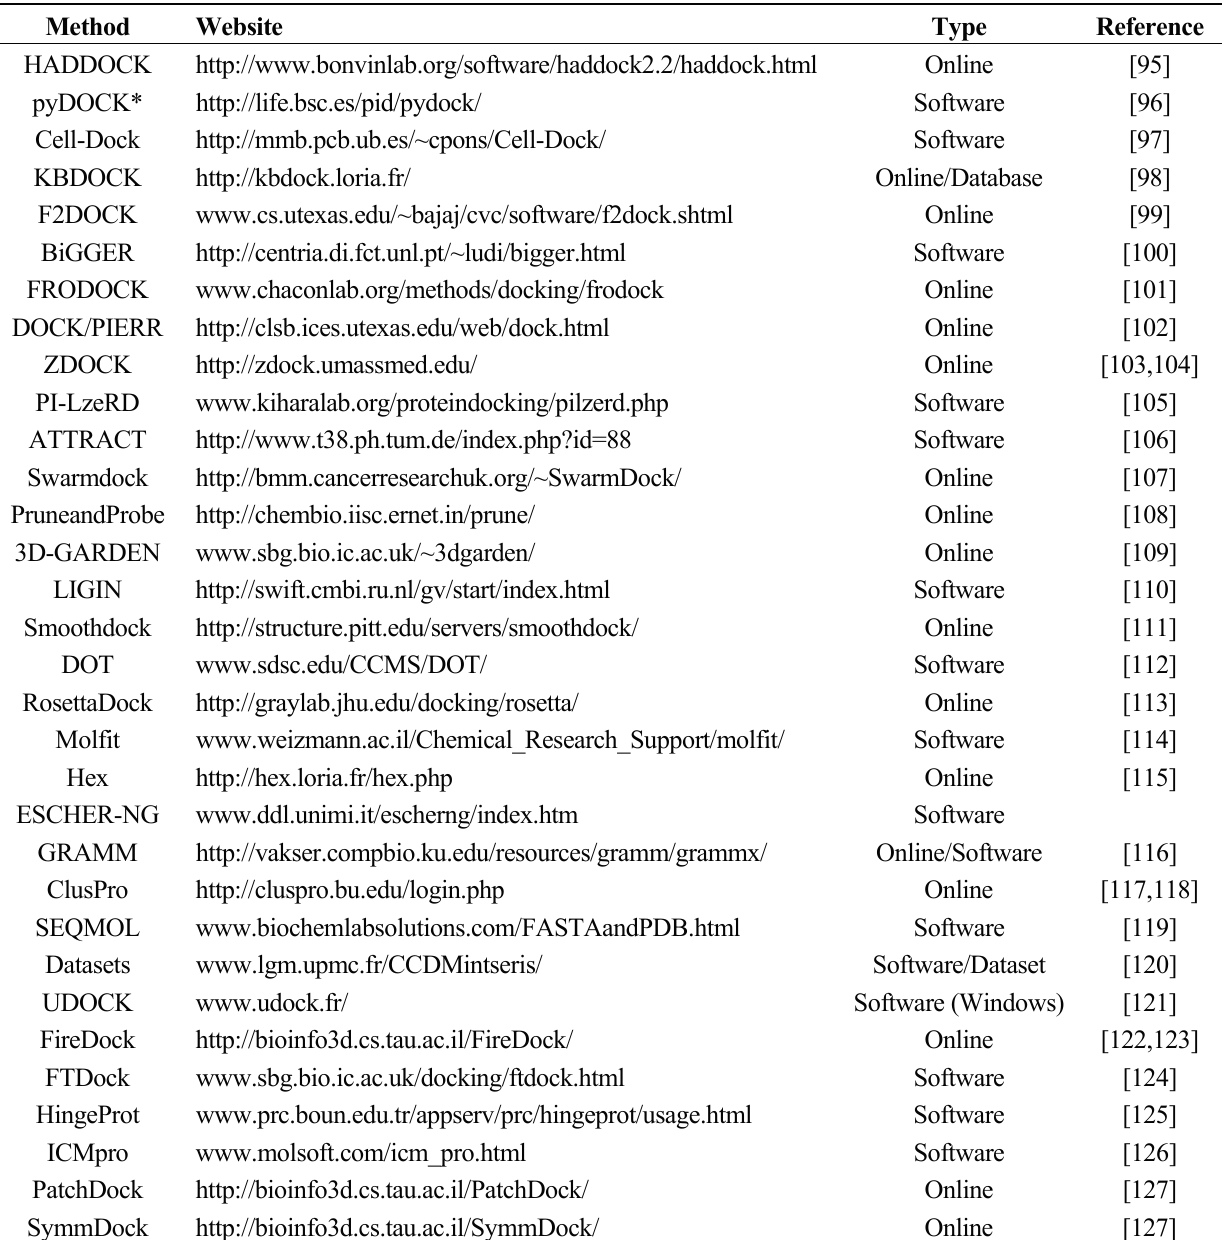
Table 2. List of protein-protein docking